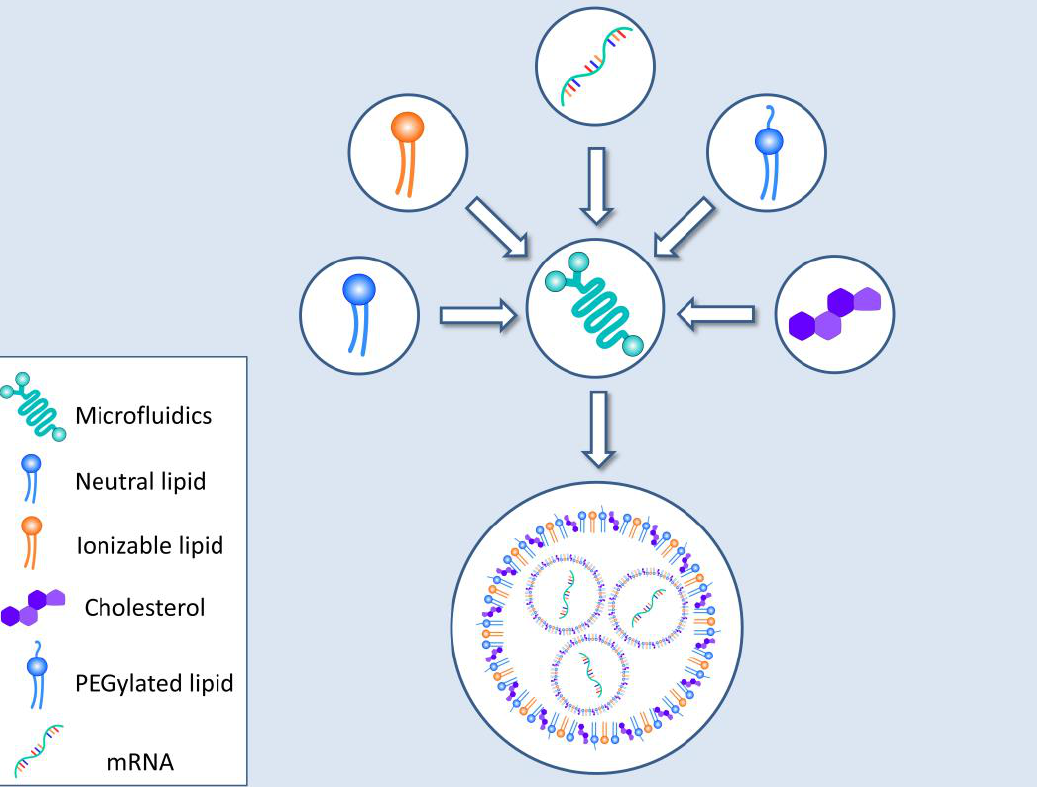
Figure 4. Lipid nanoparticle formation. LNPs are nowadays made by utilizing microfluidic technology which yields a uniform and well characterized final product. The encapsulation material (various natural or modified lipids) is fed into the device alongside with the mRNA. The resulting mRNA–LNPs are further purified to ensure suitability for human use.